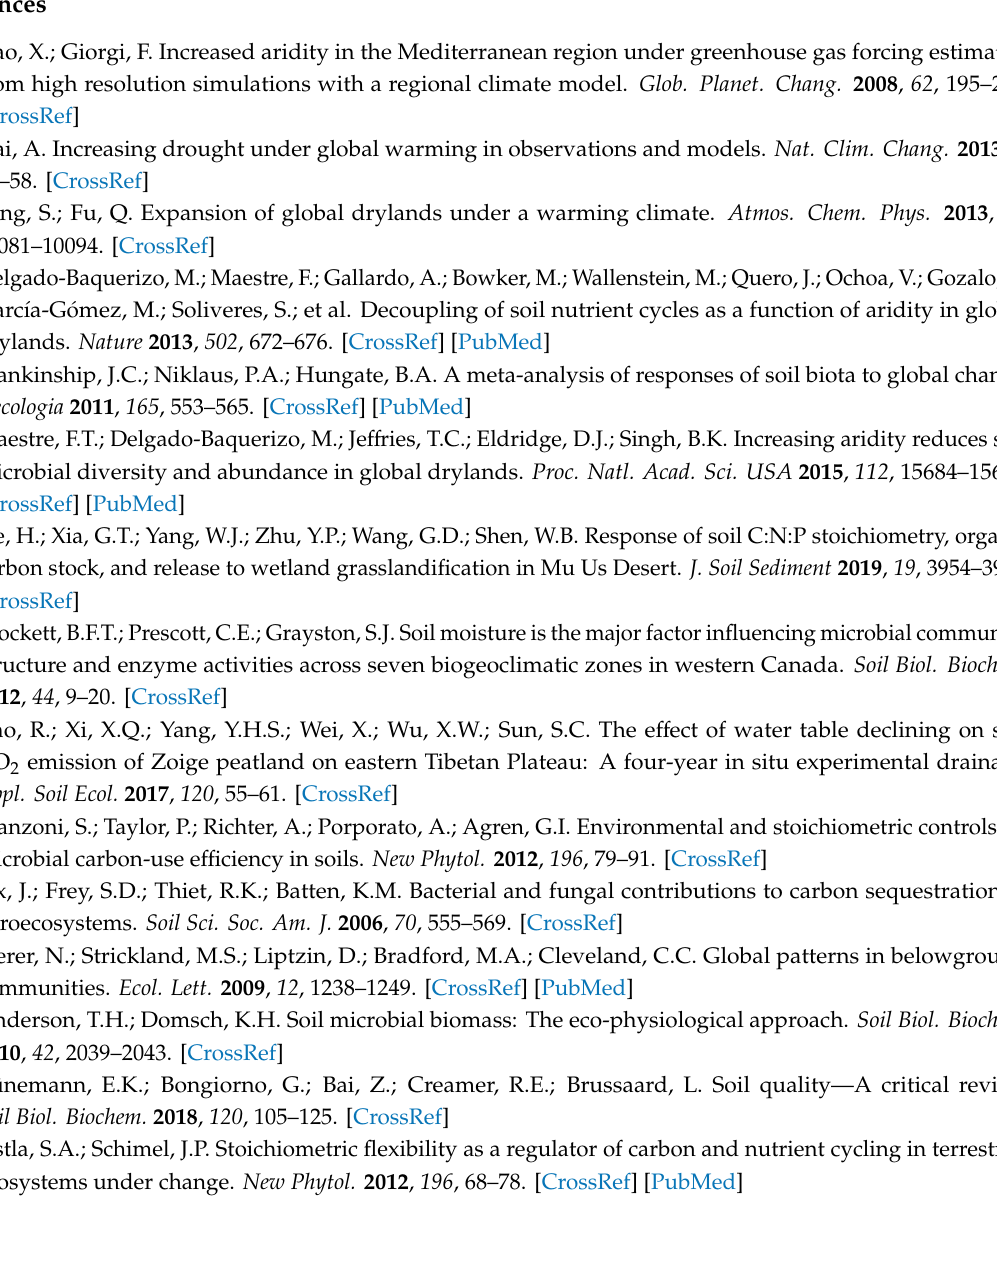
succession stages on litter chemical properties in June and October, Table S4: Chemical properties of litters in di ff erent stages of wetland drying process in June, Table S5: Chemical properties of litters in di ff erent stages of wetland drying process in October, Table S6: Summary statistics (F statistic and probability level) of a one-way ANOVA on the e ff ects of di ff erent succession stages on soil physical and chemical properties in June and October, Table S7: Summary statistics (F statistic and probability level) of a one-way ANOVA on the e ff ects of di ff erent succession stages soil microbial properties in June and